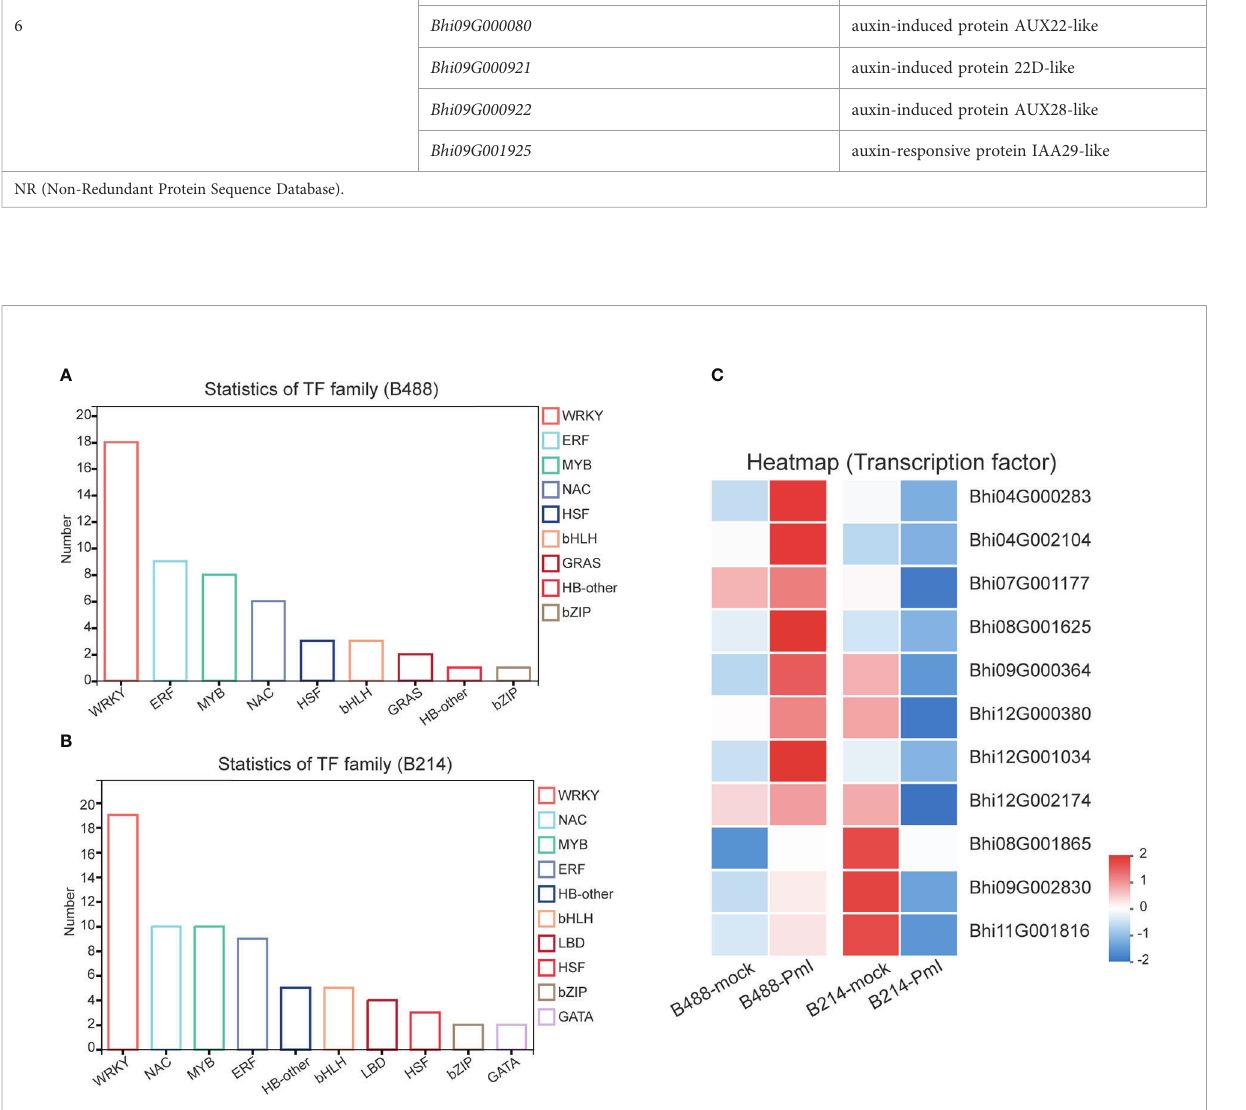
FIGURE 6 TF family of DEGs. (A) Statistics for TF in B488 (mock infection vs. PmI). (B) Statistics of TF in B214 (mock infection vs. PmI). (C) Heatmap of differentially expressed TF genes between B488 (mock infection vs. PmI) and B214 (mock infection vs.